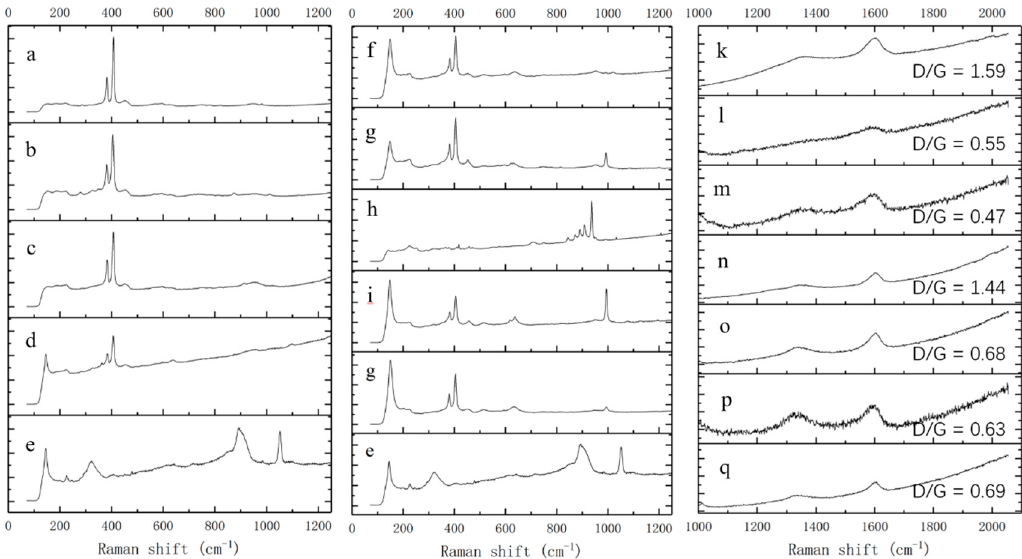
Figure 10. Laser Raman spectra of CATs at different status and coke formations ( a ) served 1 year; ( b )